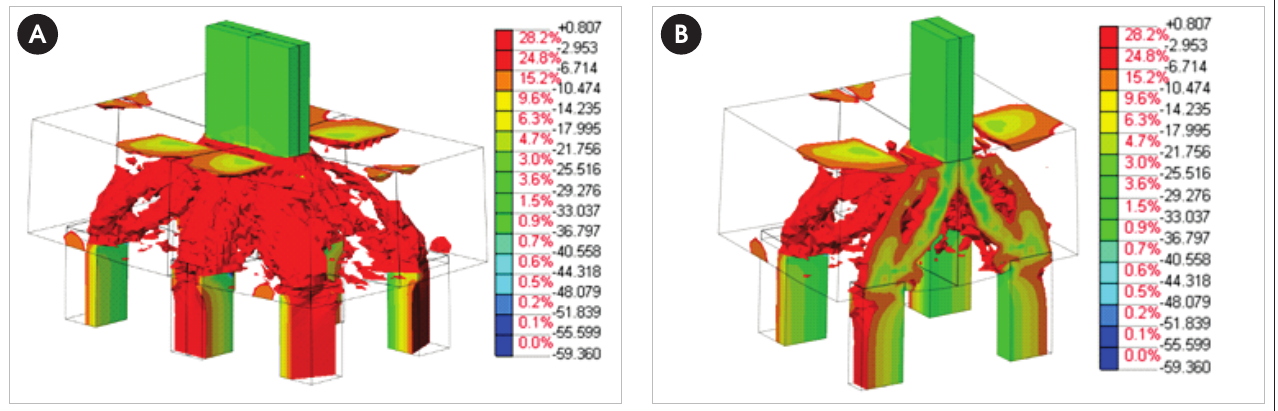
Figure 15 – Principal compressive stress. Surface where acts a stress of -6MPa on pile cap B-4-30-600: